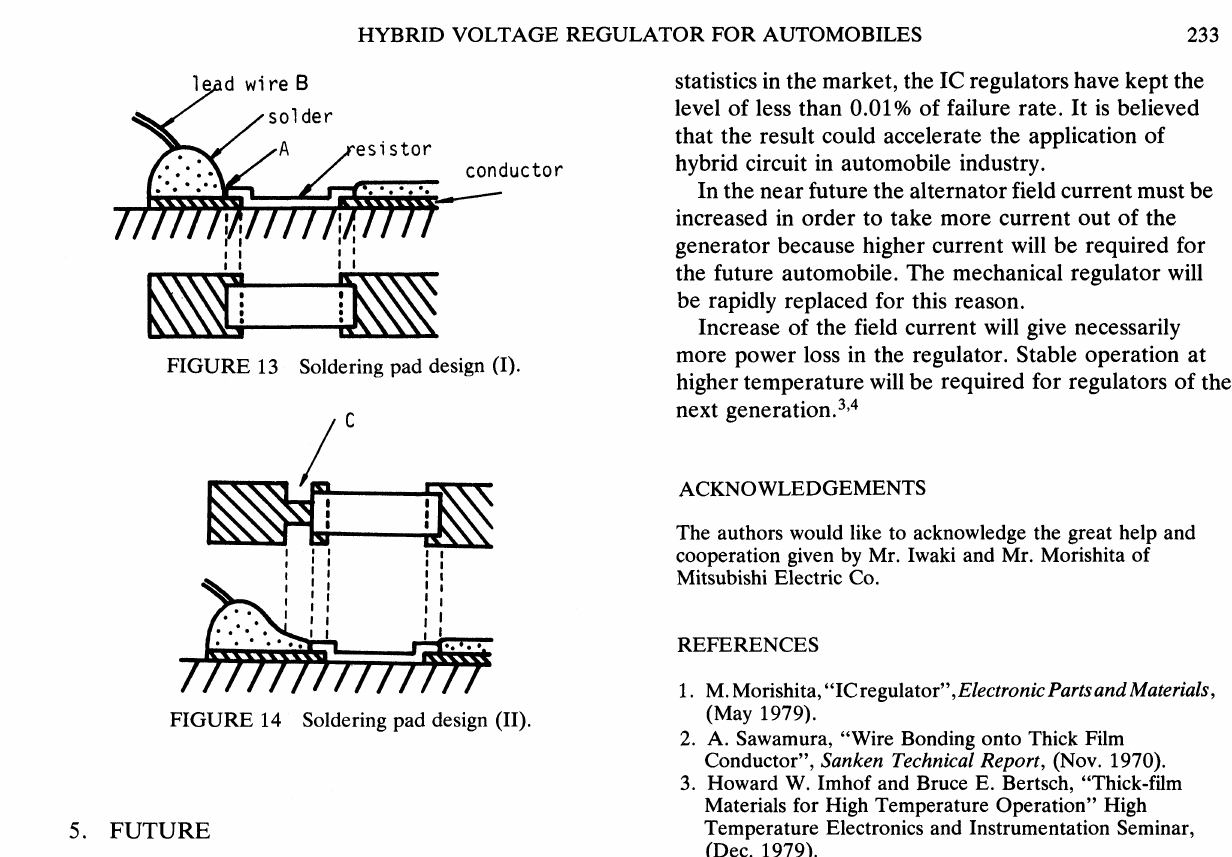
FIGURE 13 Soldering pad design (I).